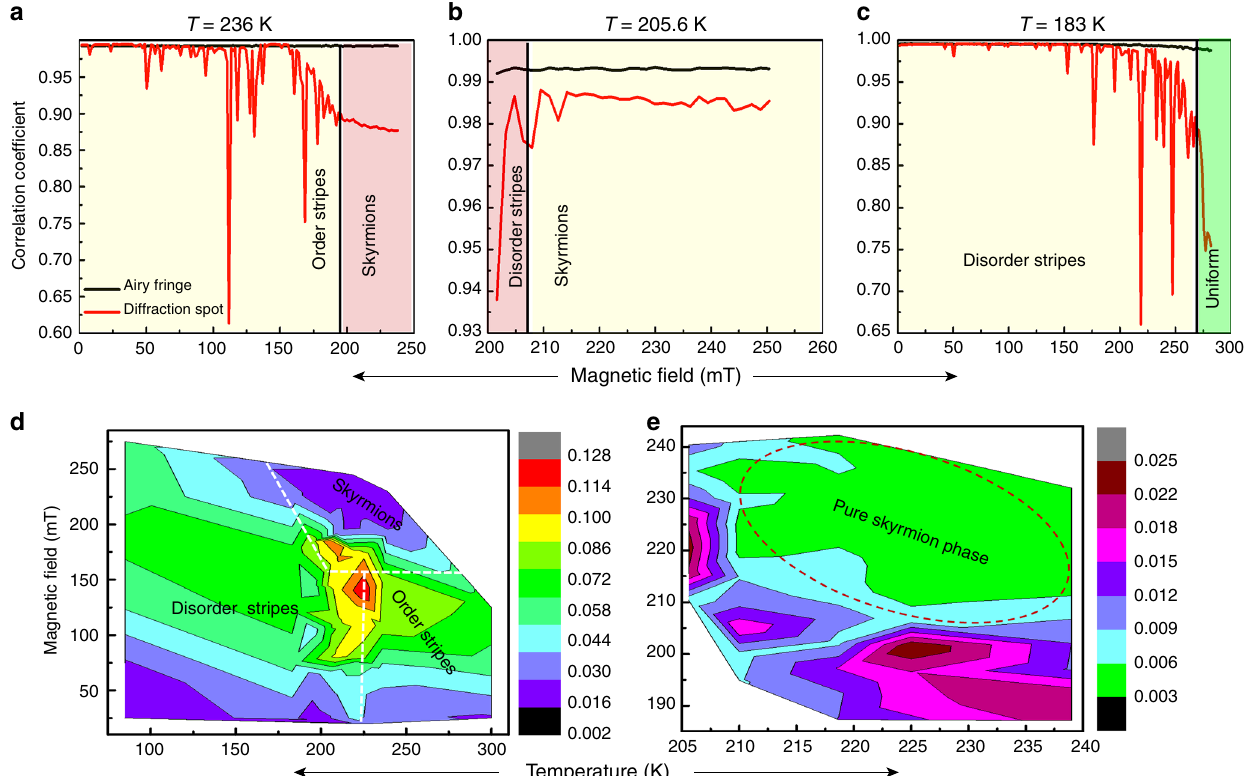
Fig. 4 Average size of domain jump as a function of temperature and applied fi eld: Plot of cross-correlation function (red line) versus magnetic fi eld for ( a ) order stripe, ( b ) skyrmion, and ( c ) disorder stripe diffraction spots. The black line in the fi gures corresponds to the correlation value from non-magnetic region (airy fringes). Correlation between two consecutive image patterns was done for those regions as mentioned in Fig. 1 with the corresponding color boxes. The size and position of the boxes was maintained to be same for the entire fi eld range. Color bar represents average jump size. Contour plot of average jumps size 〈 X 〉 as a function of fi eld and temperature for ( d ) entire magnetic phase and ( e ) skyrmion phase only. A peak in the jump size in ( d ) (red area ≈ 225 K, 150 mT) suggests a critical